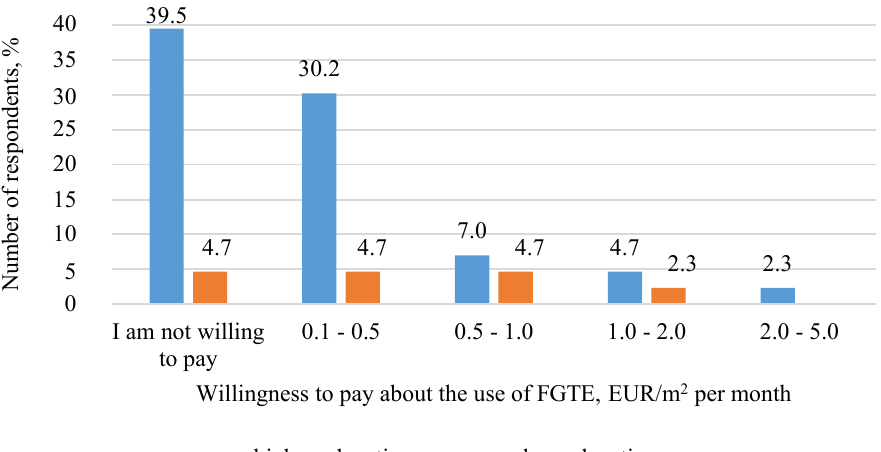
Fig. 8. Respondents’ willingness to pay about the use of FGTE from the view of education